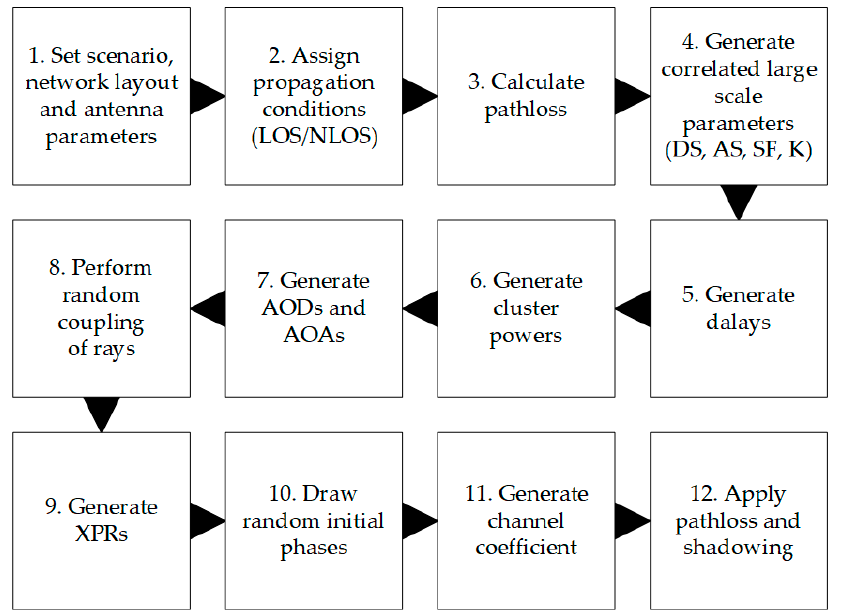
Figure 3. Block diagram of statistical channel model reconstruction according to 3GPP.